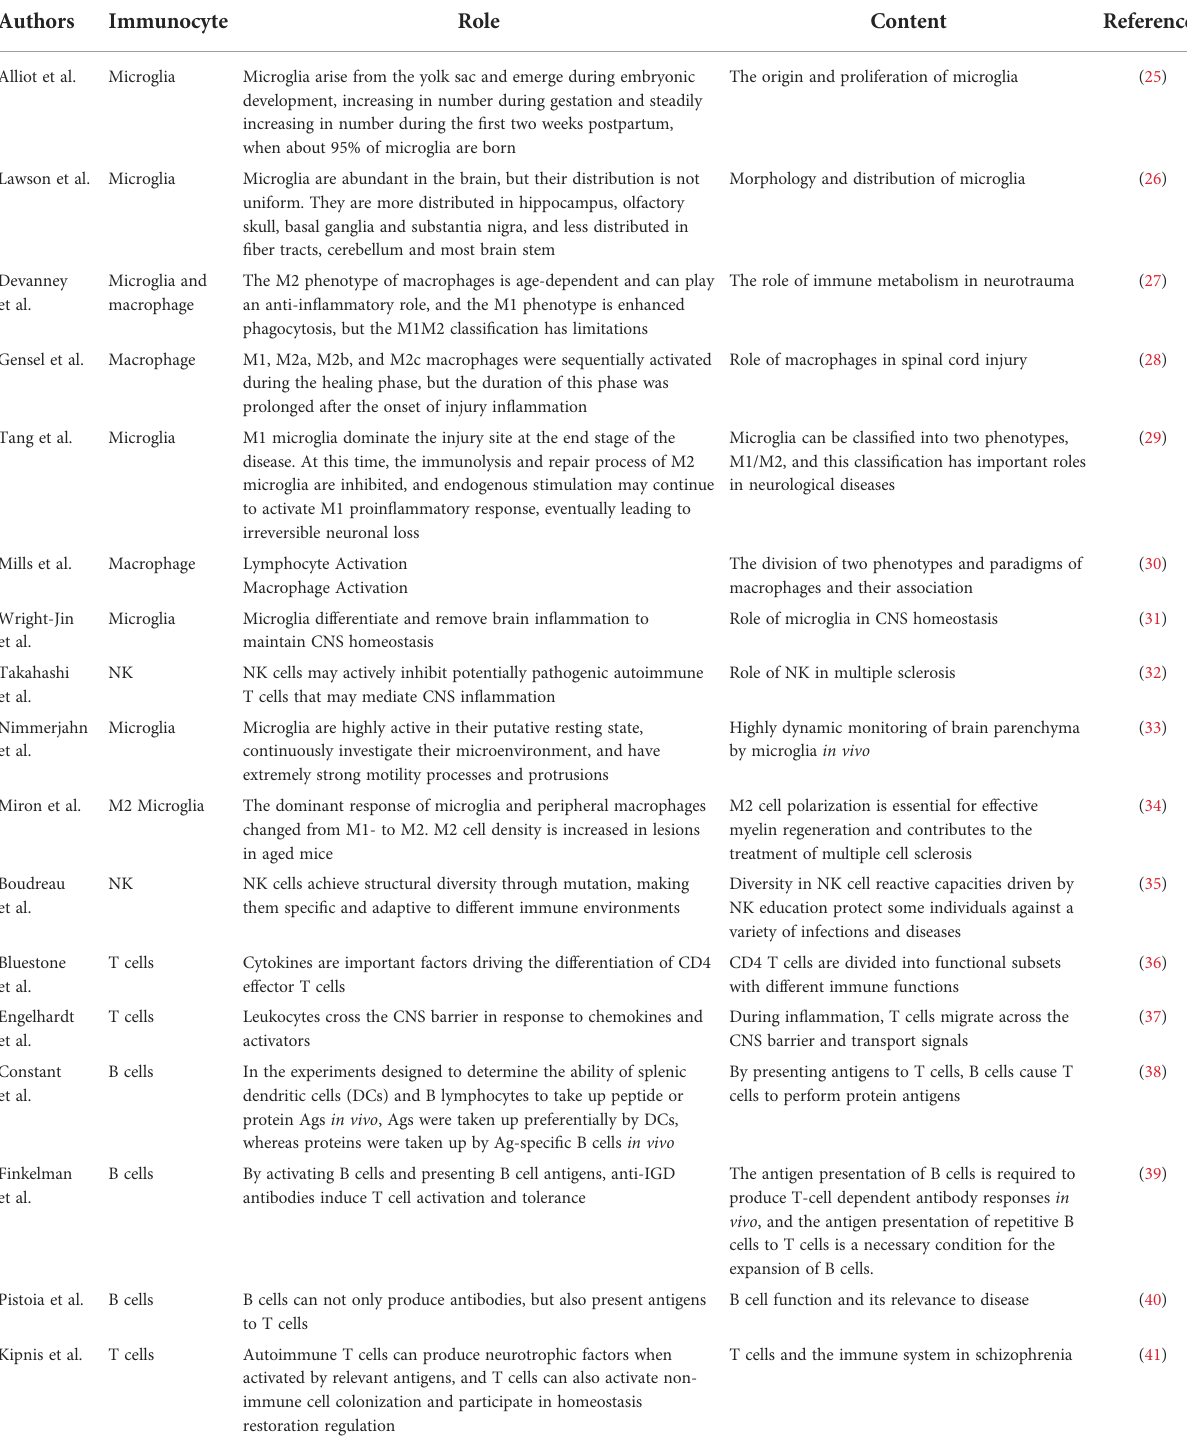
TABLE 1 The distribution, roles, types and relationships of immune cells in the CNS. Authors